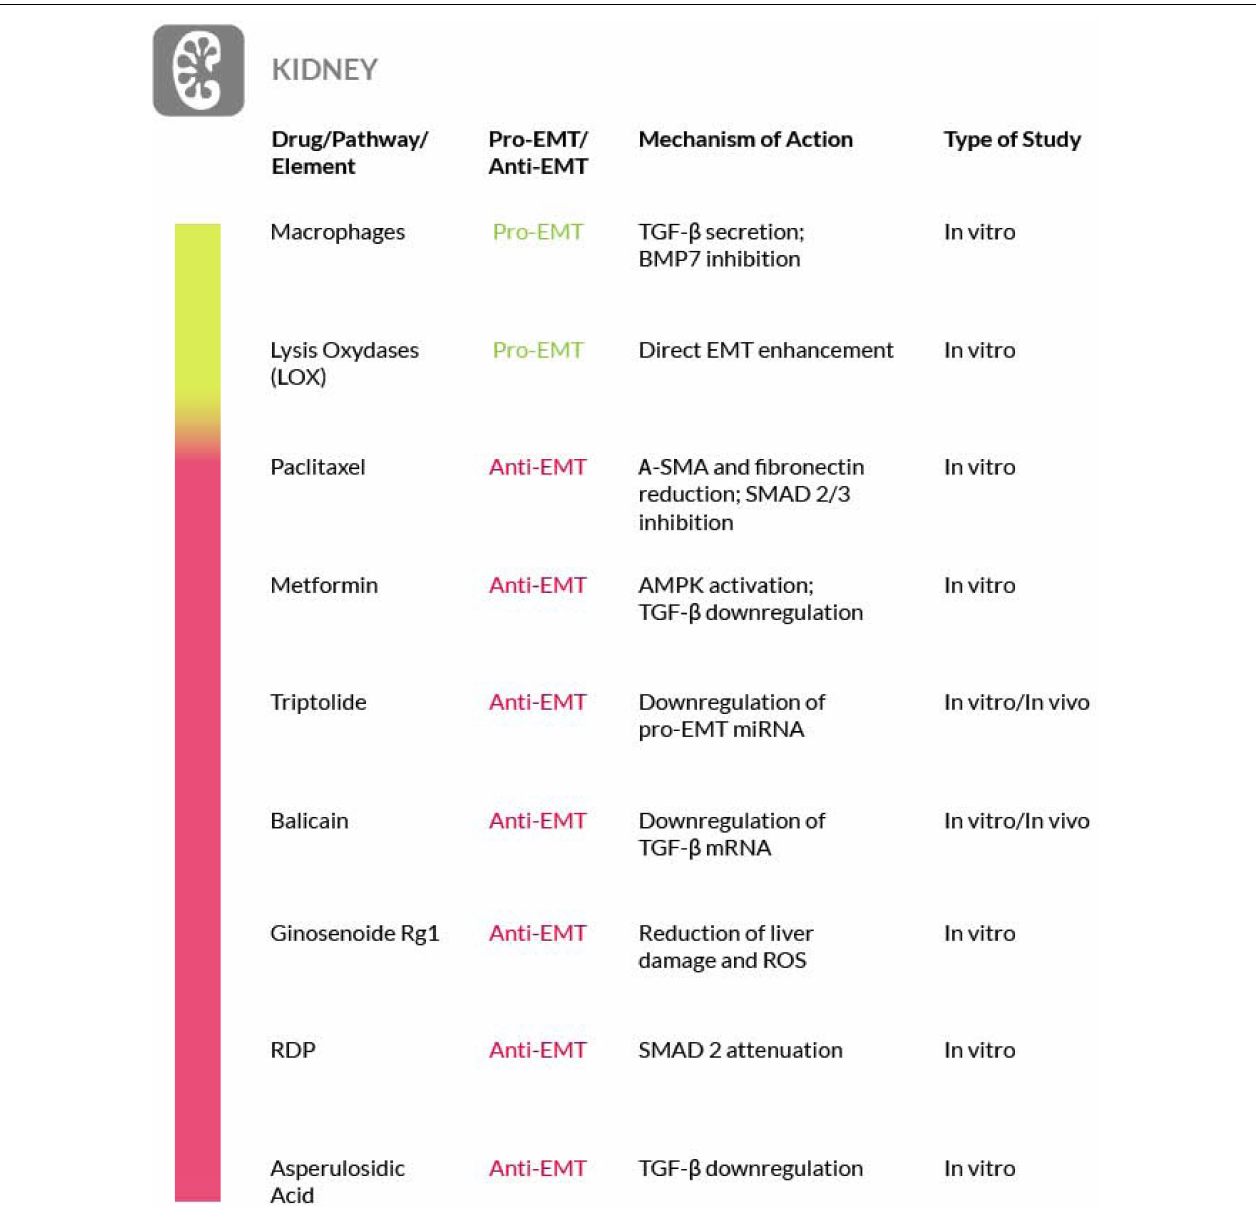
FIGURE 5 | Most relevant molecular mechanisms and possible drugs for the treatment of EMT in renal